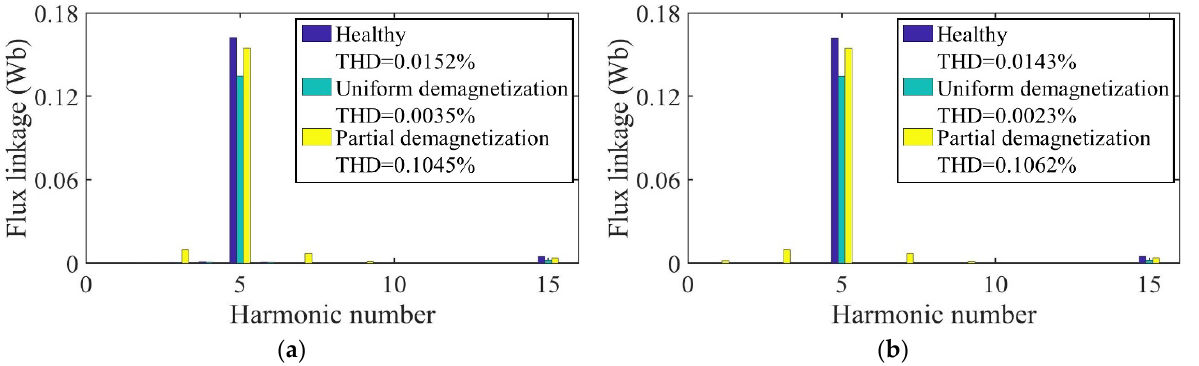
Figure 19. Harmonics in the flux-linkage relative to fundamental wave at fs = 166.67 Hz. ( a ) Analytical model; ( b ) FE model.